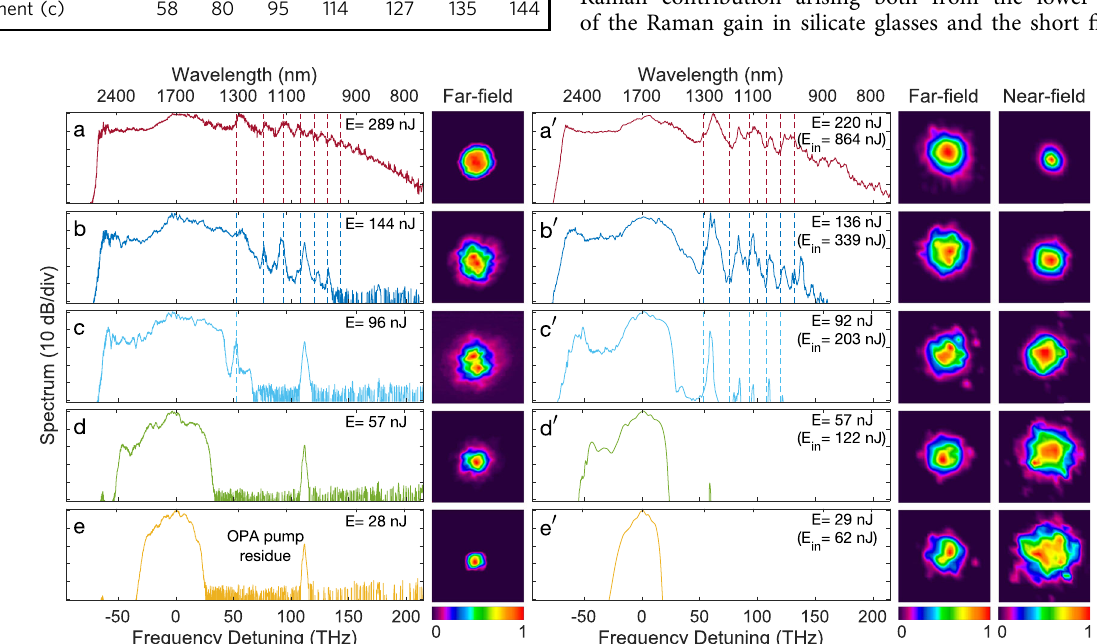
Fig. 4 Supercontinuum spectra and corresponding far- fi eld spatial intensity distribution as a function of output energy (E) as indicated and for a pump wavelength of 1700 nm. a – e Experimental results and a 0 (cid:2) e 0 3 + 1D numerical simulations (see Methods for details). The numerical simulations show both the far- fi eld and near- fi eld spatial intensity distributions, and the input energy E in is also indicated. The vertical dotted lines mark the theoretical GPI frequencies. The spectral peak at a relative detuning of 111 THz (1040 nm) is a residue from the OPA pump